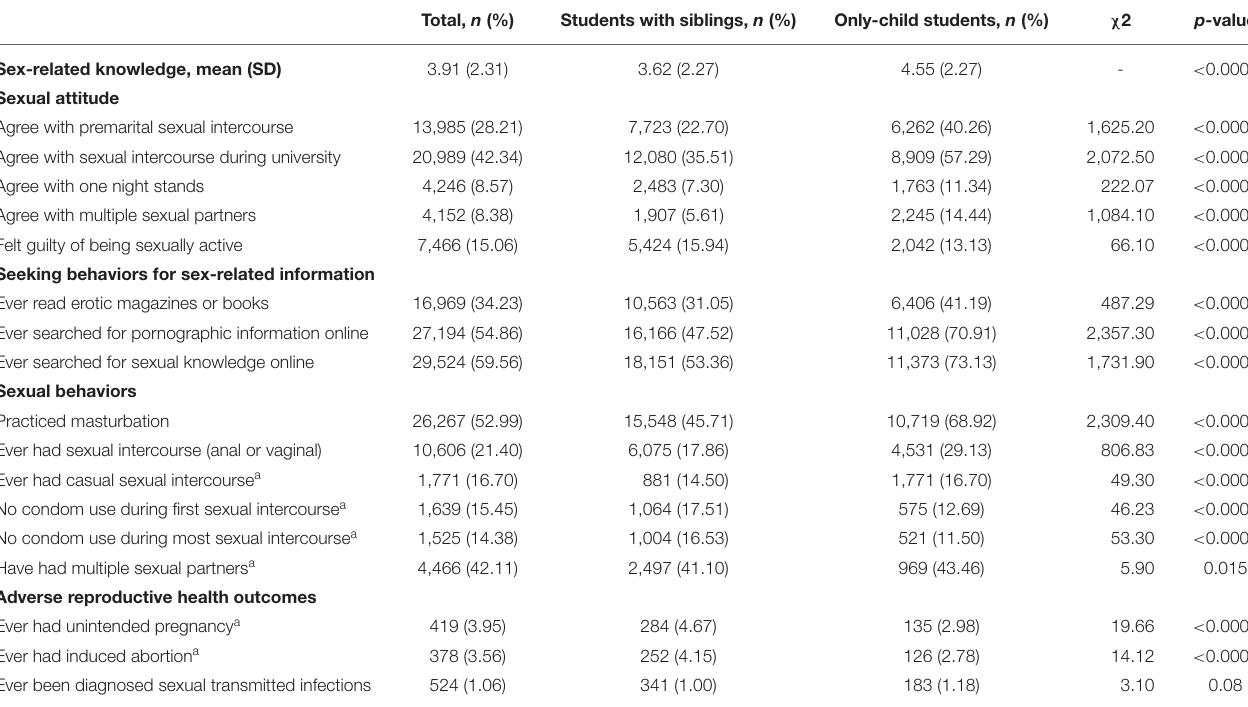
TABLE 2 | Sex-related knowledge, attitudes behaviors and SRH outcomes between only-child students and students with siblings. Total, n (%) Students with siblings, n (%) Only-child students, n (%) χ 2 p